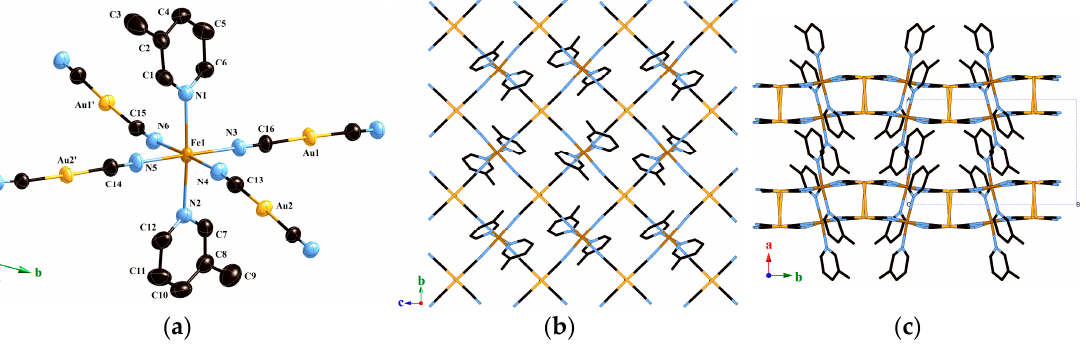
Figure 2. ( a ) Coordination structure of compound 2 containing its asymmetric unit at 293 K; ( b ) View of the 2-D layer structure of 2 ; ( c ) Stacking of four consecutive layers of 2 at 293 K. In these pictures, hydrogen atoms are omitted for